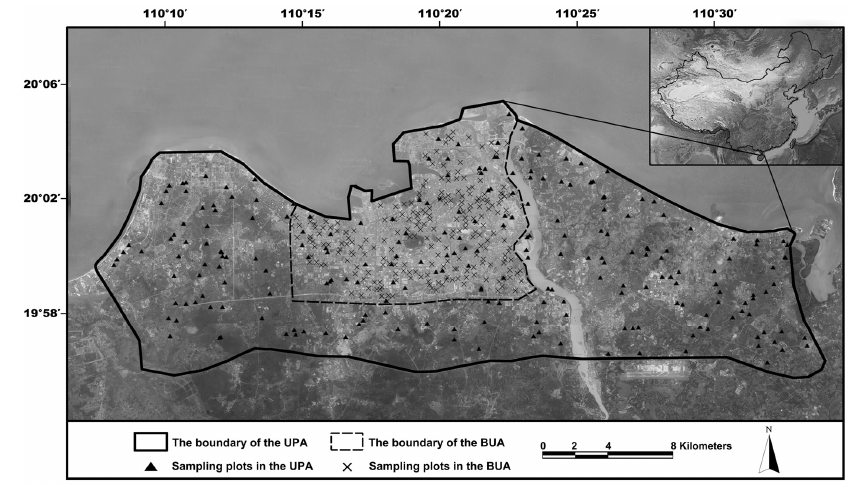
Figure 1. Map showing the boundaries of the built-up area (BUA) and the urban planning area (UPA) and locations of sampling plots.